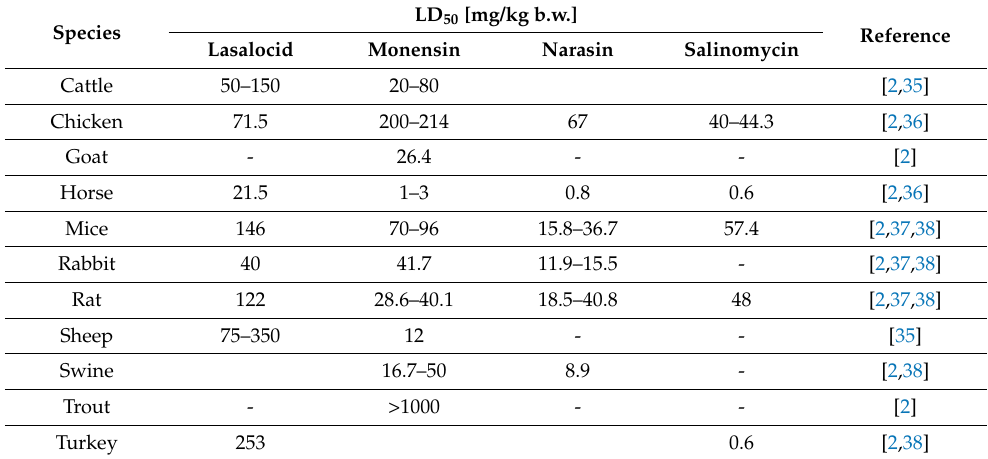
Table 3. Toxicity of the ionophores to different animal species, expressed as median lethal doses (LD 50 ). LD 50 [mg/kg Species